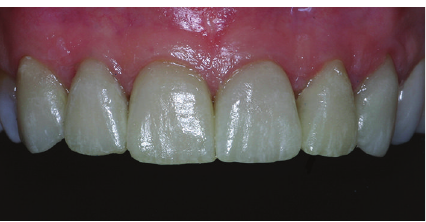
Figure 13: Temporary